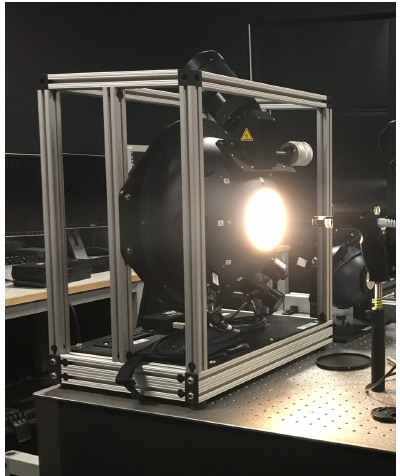
Figure 11. Diagram illustrating the steps and inputs involved dur- ing the processing of GHOST data into calibrated radiance spectra. The numbers in bold contained in each of the inputs refer to the corresponding section